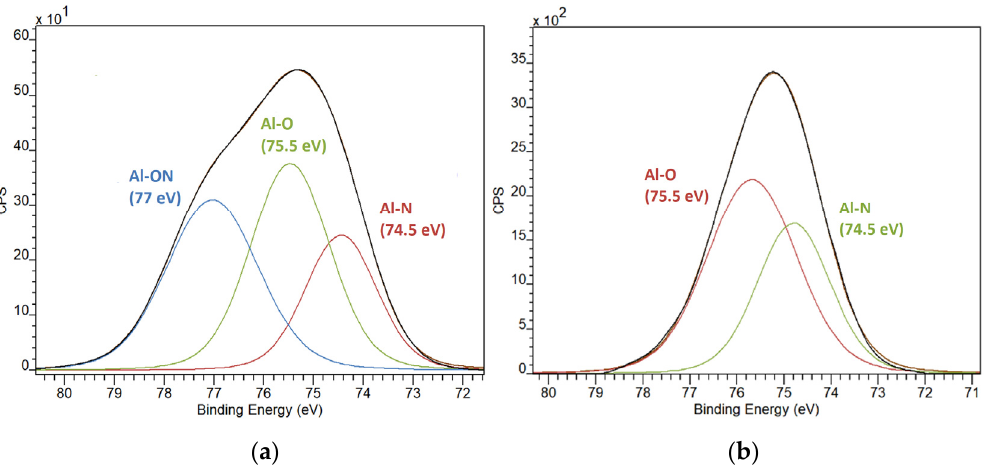
Figure 8. Comparison of high resolution Al 2p spectra of: ( a ) as-deposited AlN sample; ( b ) annealed AlN sample.